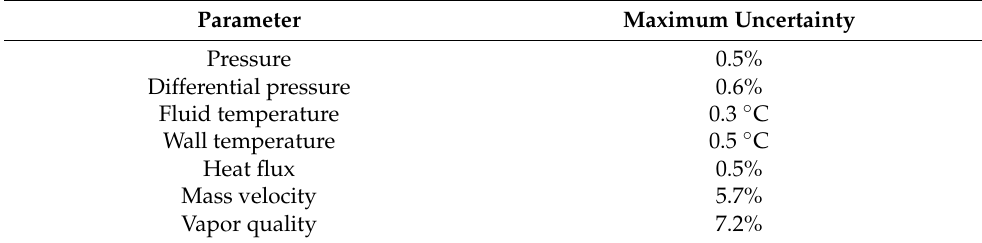
Table 2. Measurement error and uncertainty.